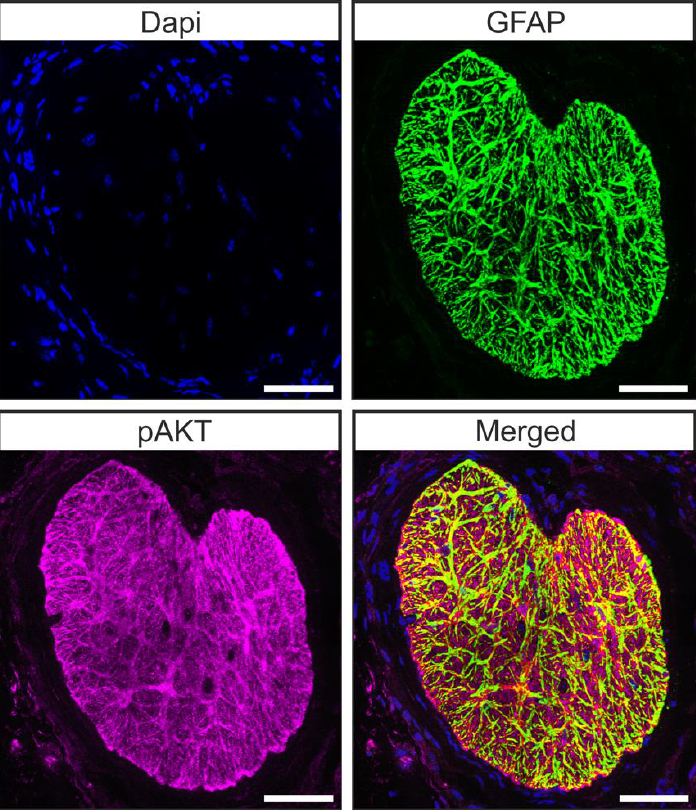
Figure 5. Astrocytes of the ON engage in pAKT/AKT signaling. Double staining against GFAP (green) and pAKT (magenta) revealed that pAKT/AKT signaling is active in astrocytes of the murine ON. Scale bars 50 µm [45].